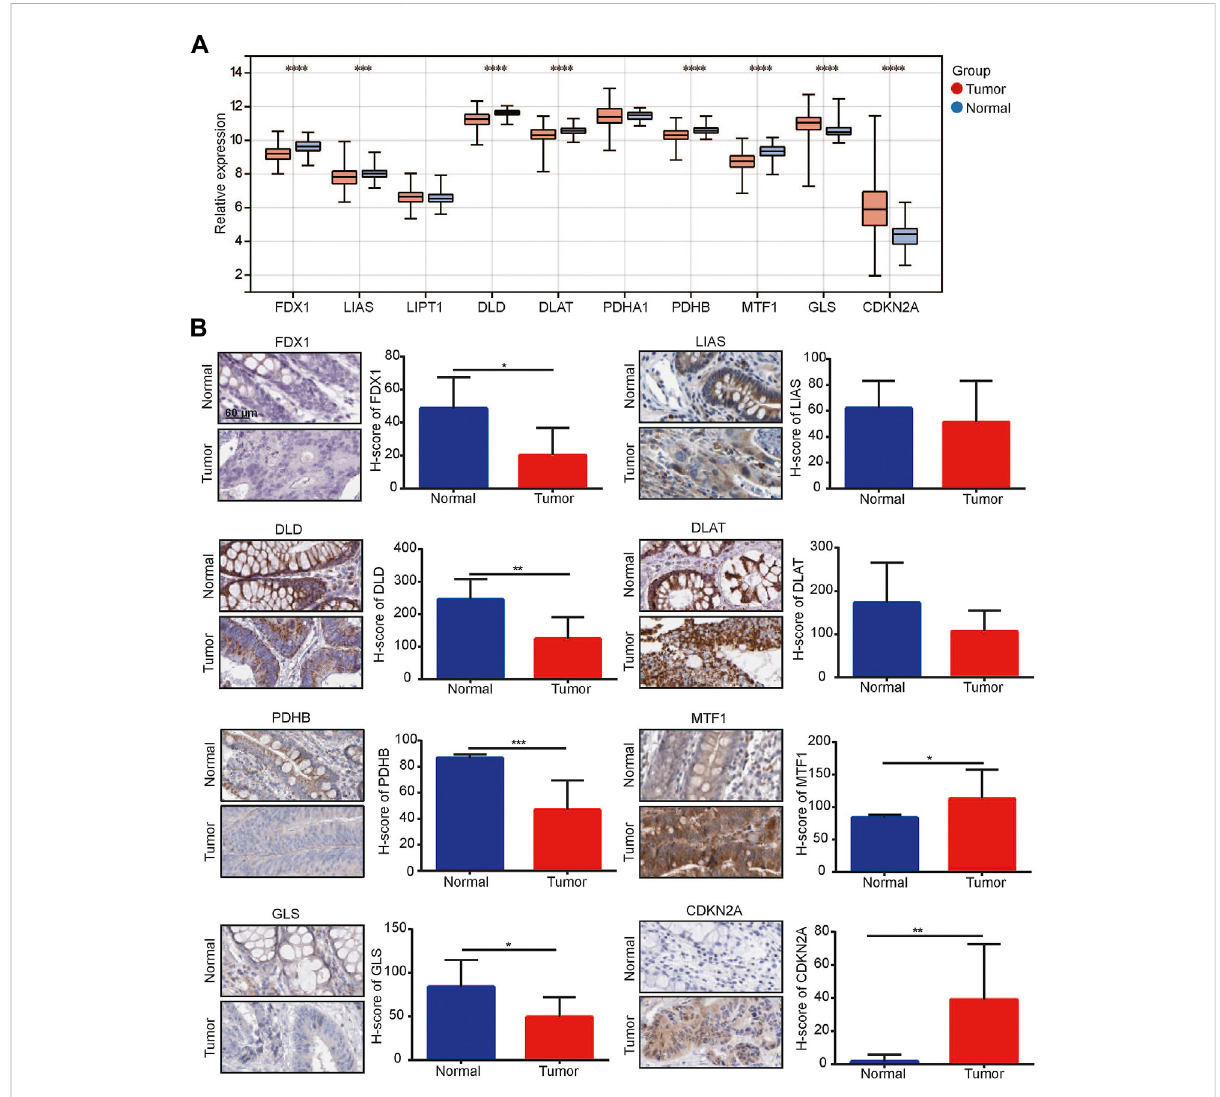
FIGURE 1 1 Cuproptosis-related genes (CRGs) was related to colorectal cancer. (A) Expression of CRGs in TCGA-colorectal cancer dataset; (B) Immunohistochemical analysis for CRG expression between normal colon/rectal tissue and colorectal cancer. * p < 0.05, ** p < 0.01, *** p < 0.001, **** p <